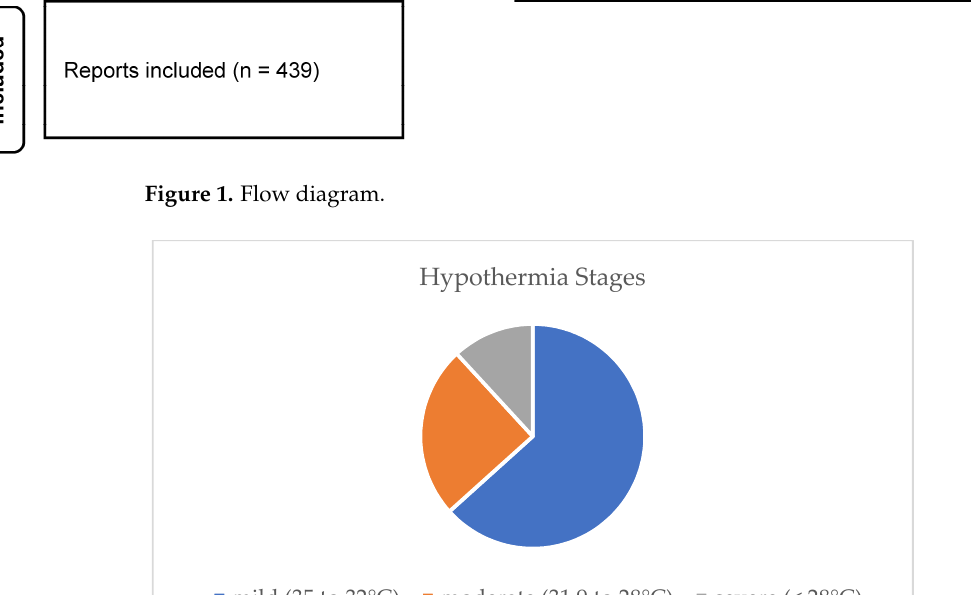
Table 1. Aetiologies (multiple answers allowed). Etiology